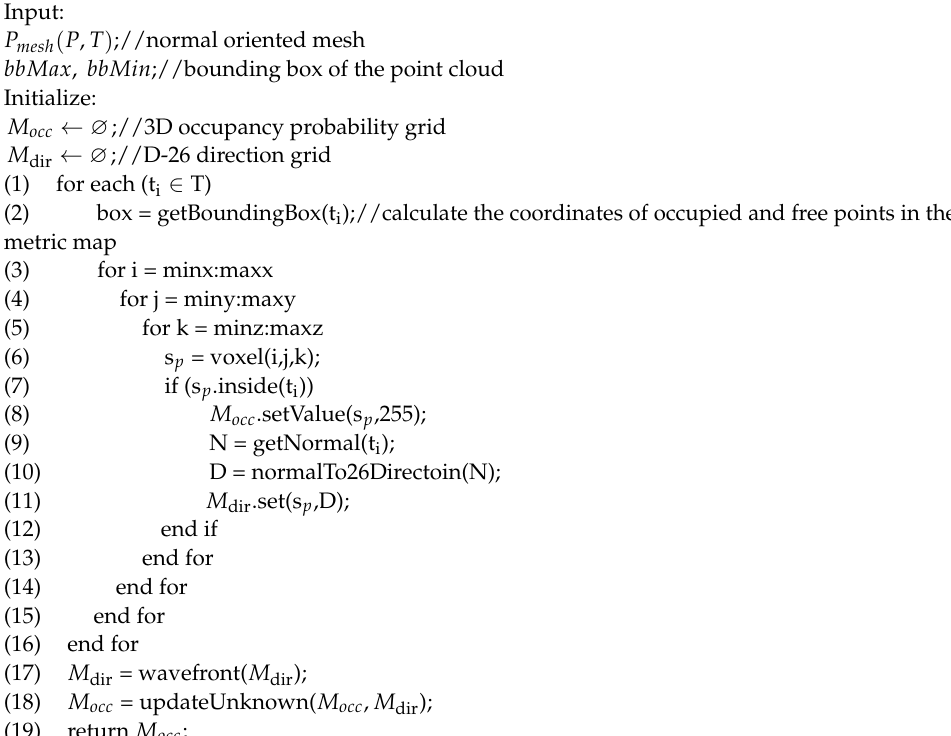
Algorithm 2. 3D occupancy probability calculation for an oriented